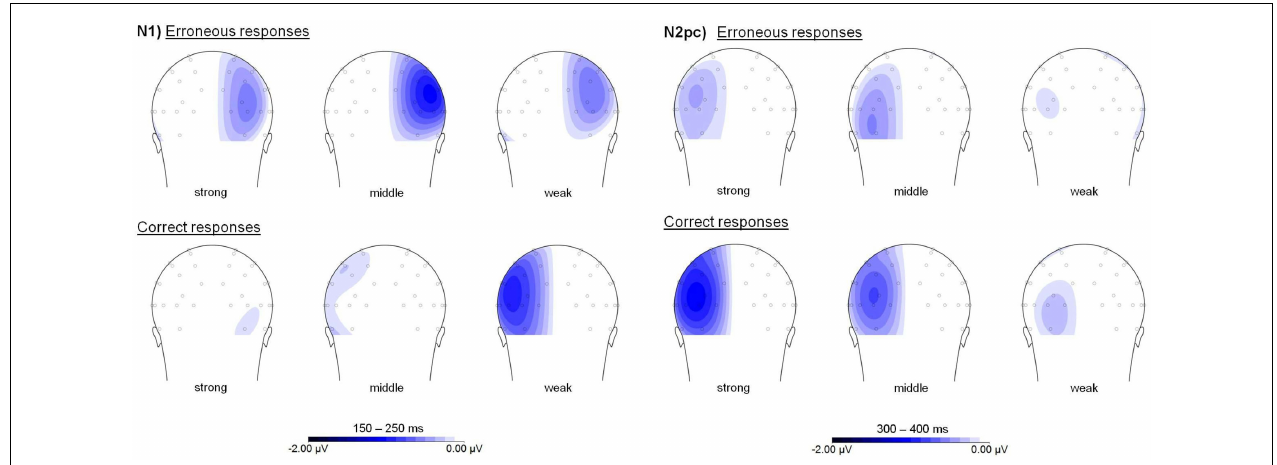
is plotted on the left hemisphere, while an asymmetry toward the motion transient is plotted on the right hemisphere.Topographies show scalp distributions in the time windows used for statistical analyses. All figures are presented on the same scale.